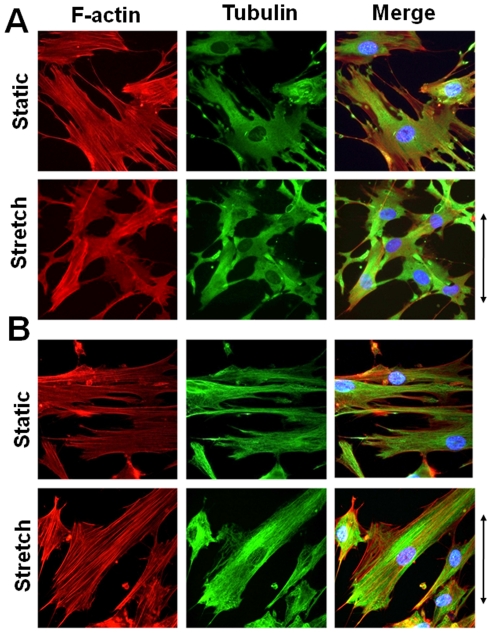
Effects of nocodazole and paclitaxel on the organization of F-actin and microtubules.Fluorescent images of the organization of F-actin stained with rhodamine-phalloidin (red) and microtubules immunostained with anti-α-tubulin antibody (green) in the static or stretched cells. Cell nuclei were stained with DAPI (cyan). The cells were pretreated with either 1 µM nocodazole (NDZ; A) or 1 µM paclitaxel (PTX; B). Arrows indicate stretch direction.